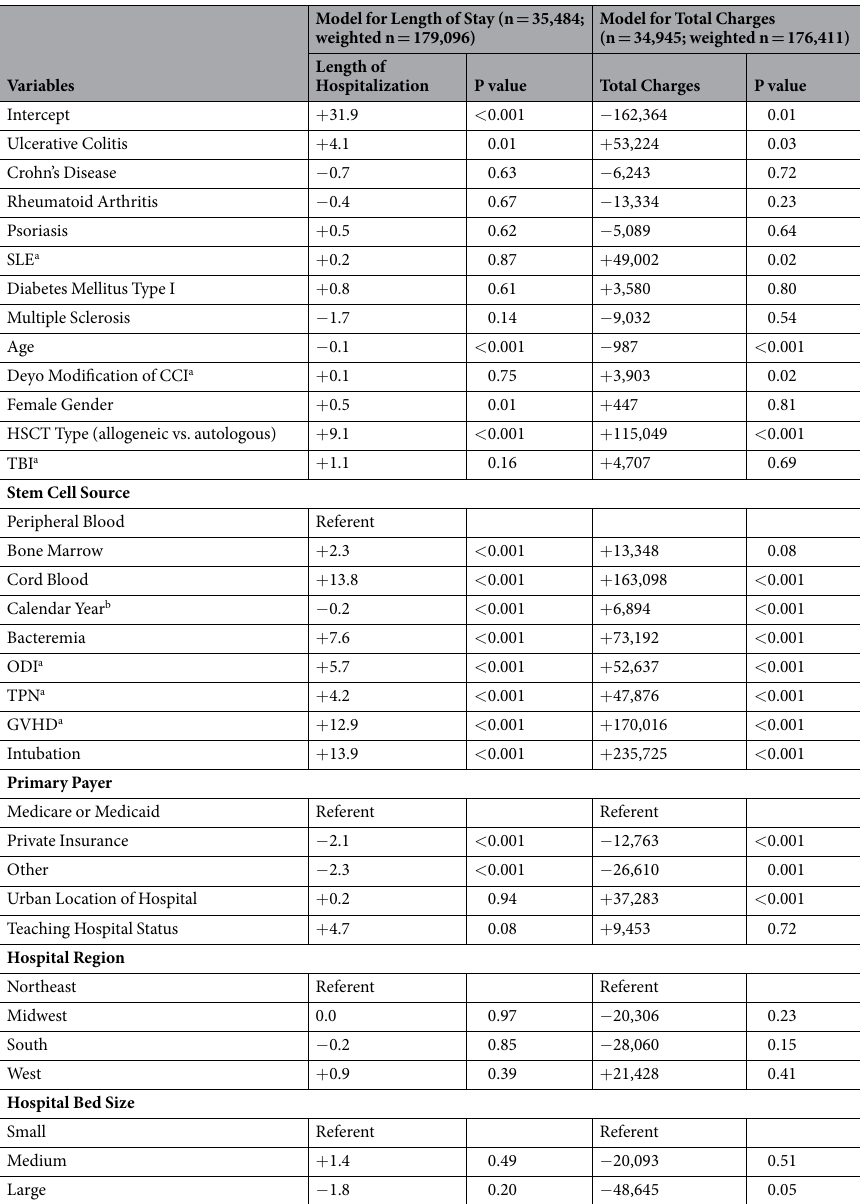
Table 5. Multivariate Predictors of Length of Stay and Total Charges for Hospitalization in Patients Receiving HSCT. a Abbreviations: CCI, Charlson Co-morbidity Indexradiation (exact match), gender (exact match),